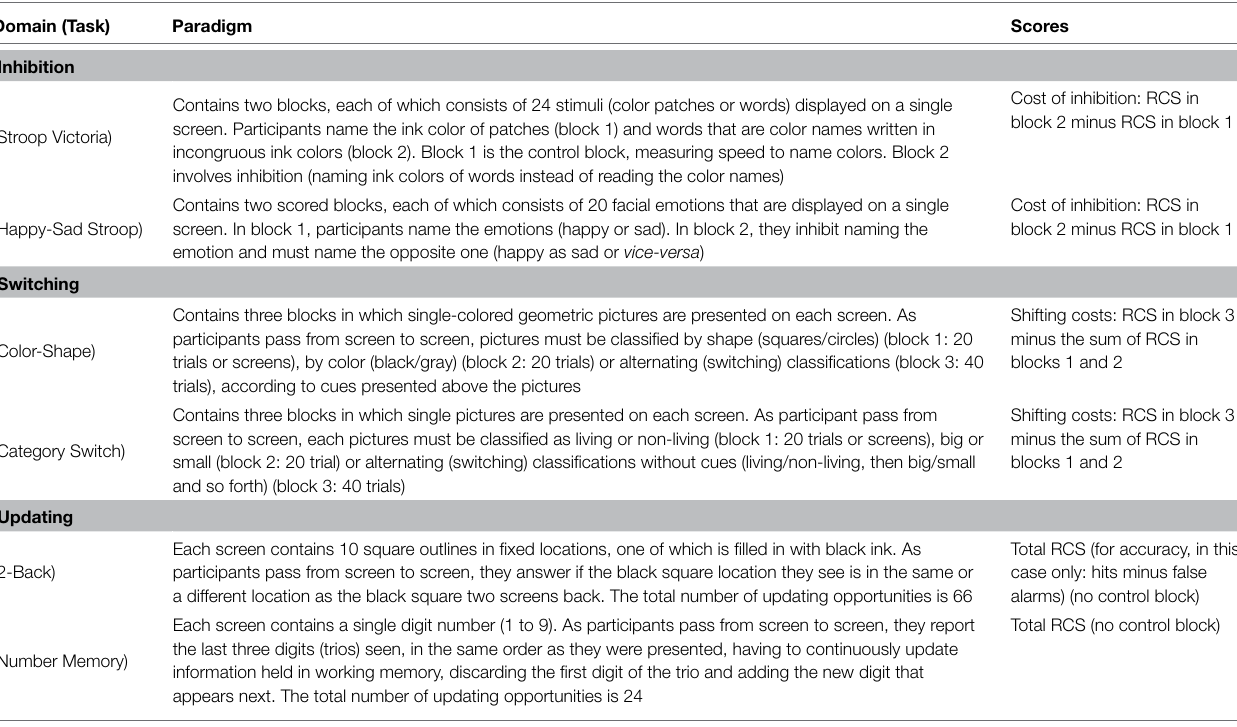
TABLE 1 | Description of the self-paced executive function tasks per domain and their corresponding scores (based on Zanini, 2021). Domain (Task)